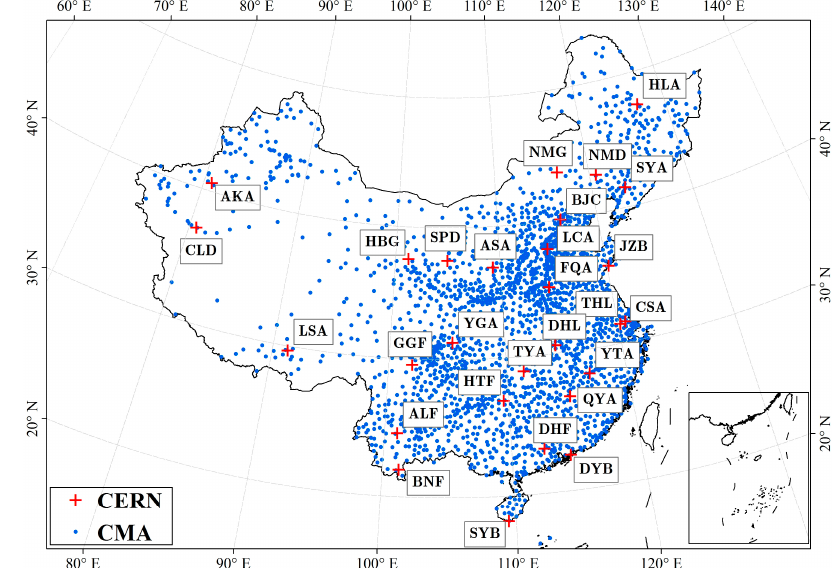
Figure 1. Spatial distribution of the CERN and Chinese Meteorological Administration (CMA) stations used in this study.